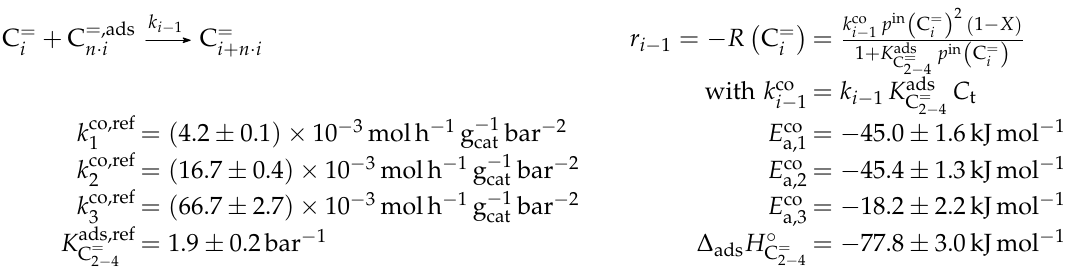
Scheme 10. Reaction network, rate equations, net rate of production of the different lumps and estimated parameters for the model by Borges et al. [165] with i ranging from 2 to 4 and n being a positive integer such that n i is a multiple of i ·